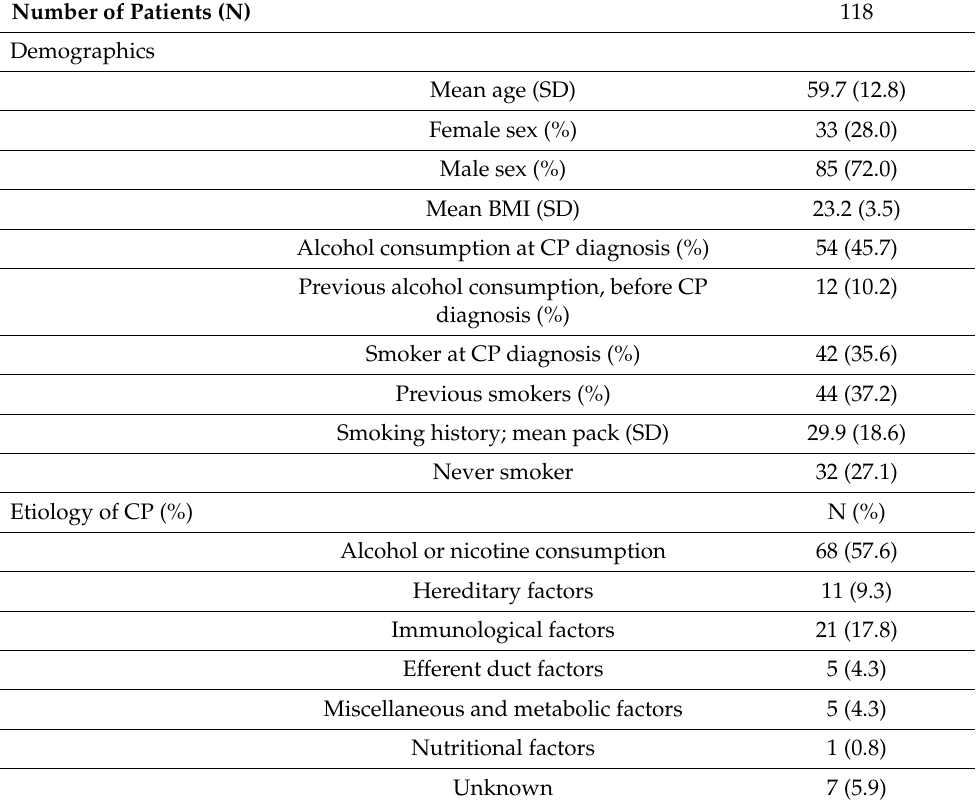
Figure 1. The process of patient selection. Table 1. Demographics and etiology of PEI patients according to the M-ANNHEIM classification of CP.